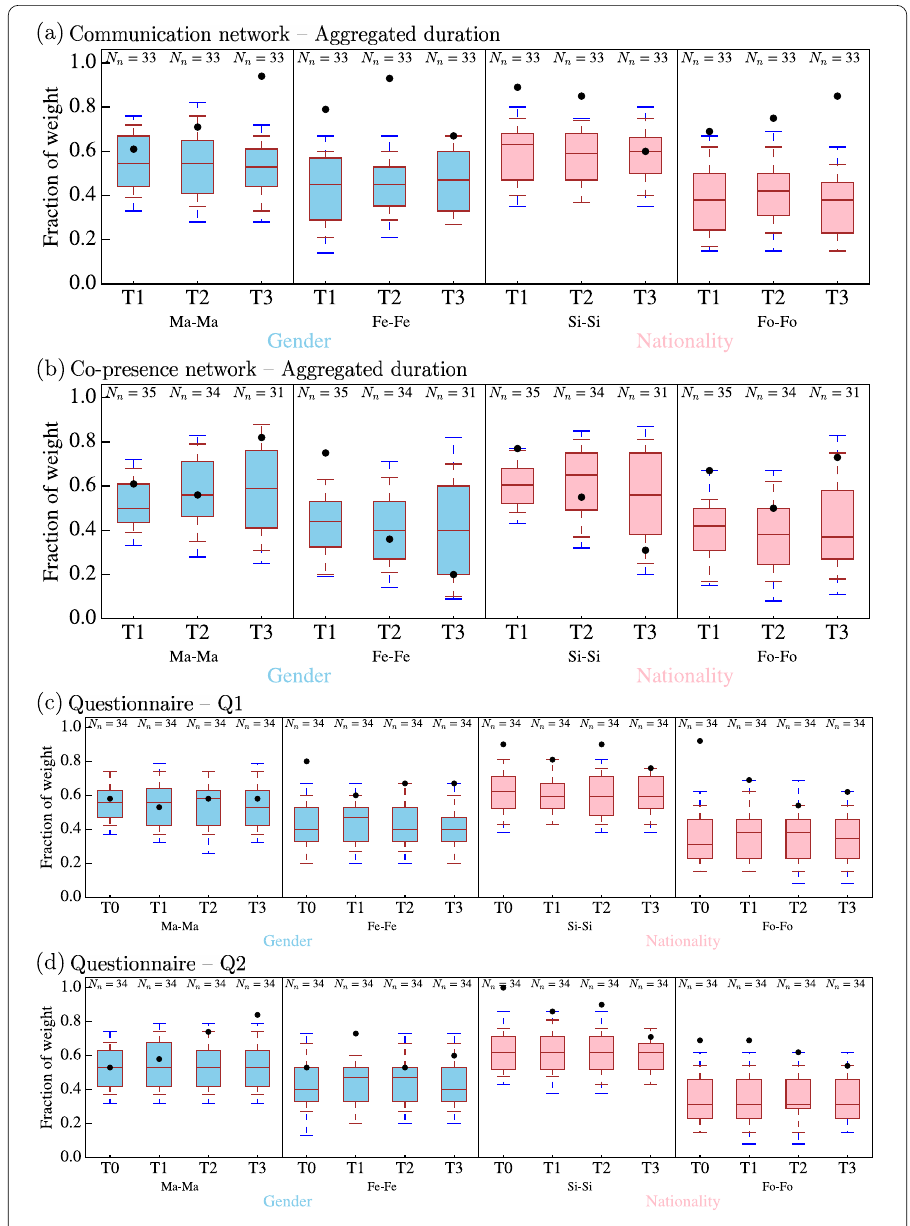
Figure 14 Concordant vs. discordant cases: Homophily in social preference in gender and nationality—term-aggregated networks. Ma: Male; Fe: Female; Si: Singaporean; Fo: Foreigner. Data (black dots) are compared with the distribution (boxplots) obtained for a null model in which attributes are reshuffled among nodes. Boxplot: Whiskers—5th, 10th and 90th, 95th percentiles; box—25th and 75th percentiles